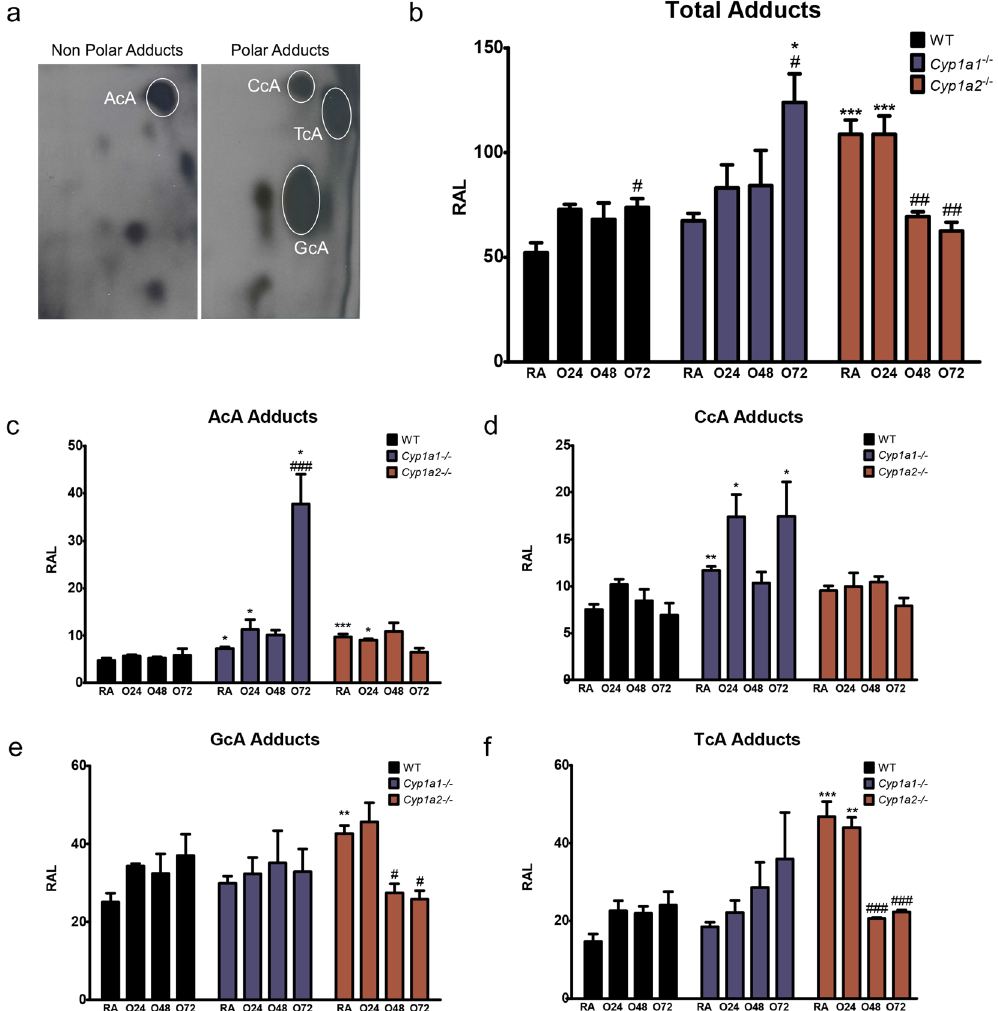
Figure 8. Pulmonary 8,5 ′ -cyclo-2 ′ -deoxyadenosine (cA) oxidative DNA adducts in WT Cyp1a1 − / − , and Cyp1a2 − / − mice exposed to hyperoxia. ( a ) Representative thin-layer chromatography maps displaying bulky oxidative DNA adducts. Polar and non-polar oxidative DNA adducts were detected by 32 P-postlabeling, as described in Materials and Methods. Panels (b–f) show quantitative analyses of total cA, AcA, CcA, GcA, and TcA adducts in the lung in WT, Cyp1a1 − / − , and Cyp1a2 − / − mice (n = 3/group) that were maintained in room air (RA) or exposed to 24, 48, and 72 hours of hyperoxia. The total cA values were derived from the addition of the individual adduct values. Two way ANOVA was used to assess statistical significance in adduct levels among genotypes and the effect of hyperoxia. Significant differences in adduct levels between WT and Cyp1a1 − / − or Cyp1a2 − / − mice is represented by * p < 0.05, ** p < 0.01 and *** p < 0.001. Significant differences between normoxic (RA) and hyperoxic animals are represented by # p < 0.05, ## p < 0.01, and ### p <